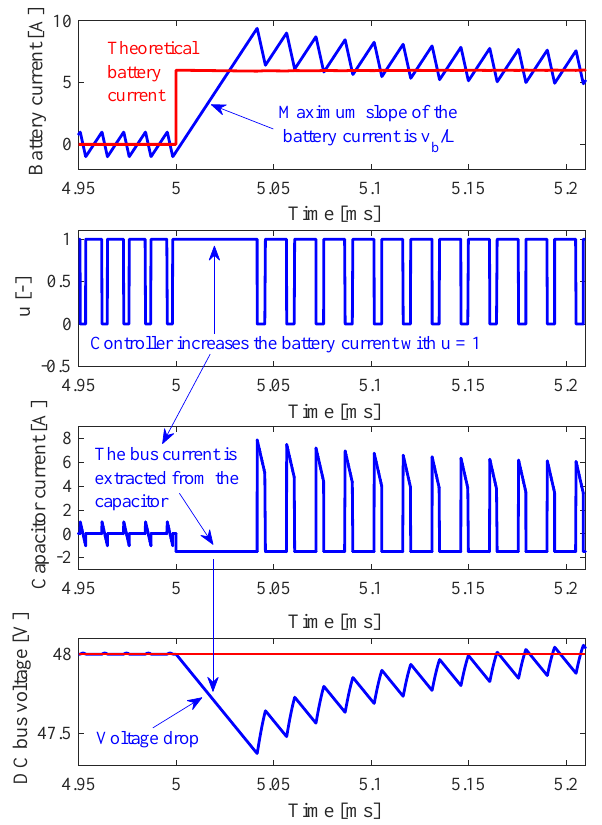
Figure 13. Simulation of the proposed controller with a step perturbation in the DC bus